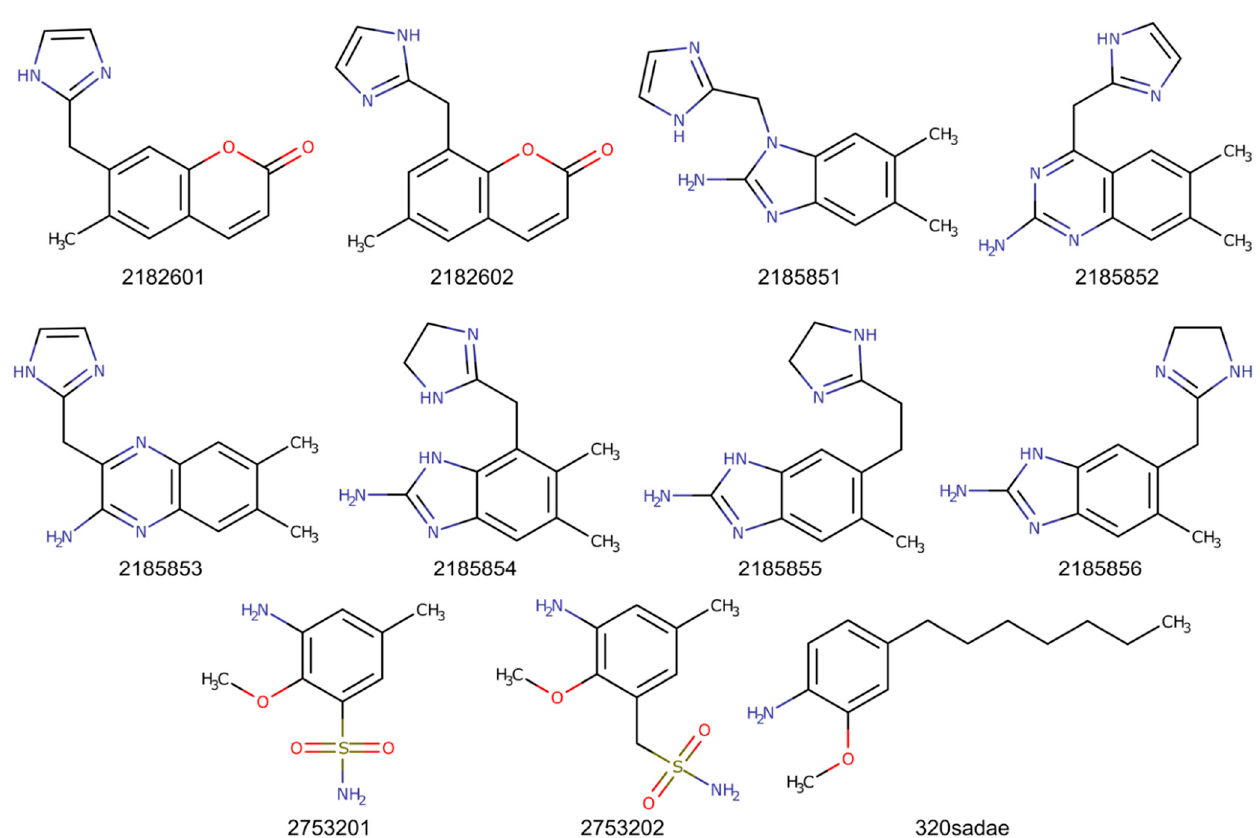
Figure 8. Chimeric compounds derived from merged fragments.